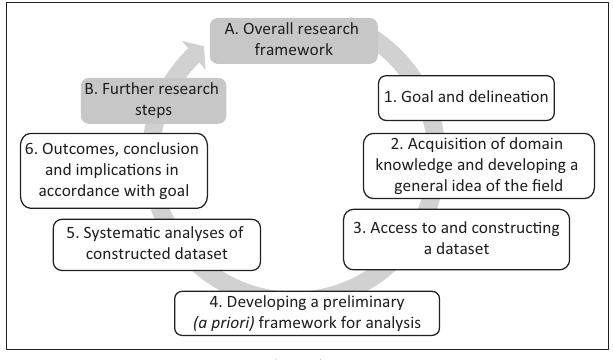
FIGURE 2: Outline of the concept analysis of